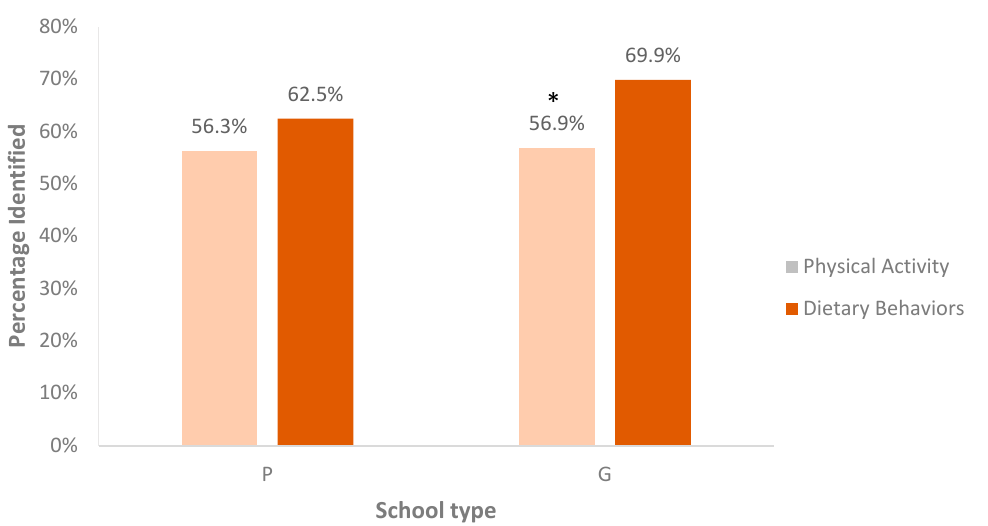
Figure 5. Percentage of “Be Fit” and “Eat Right” activities correctly classified in private (P) and government (G) schools. * Difference between P and G is statistically significant at p < 0.001.